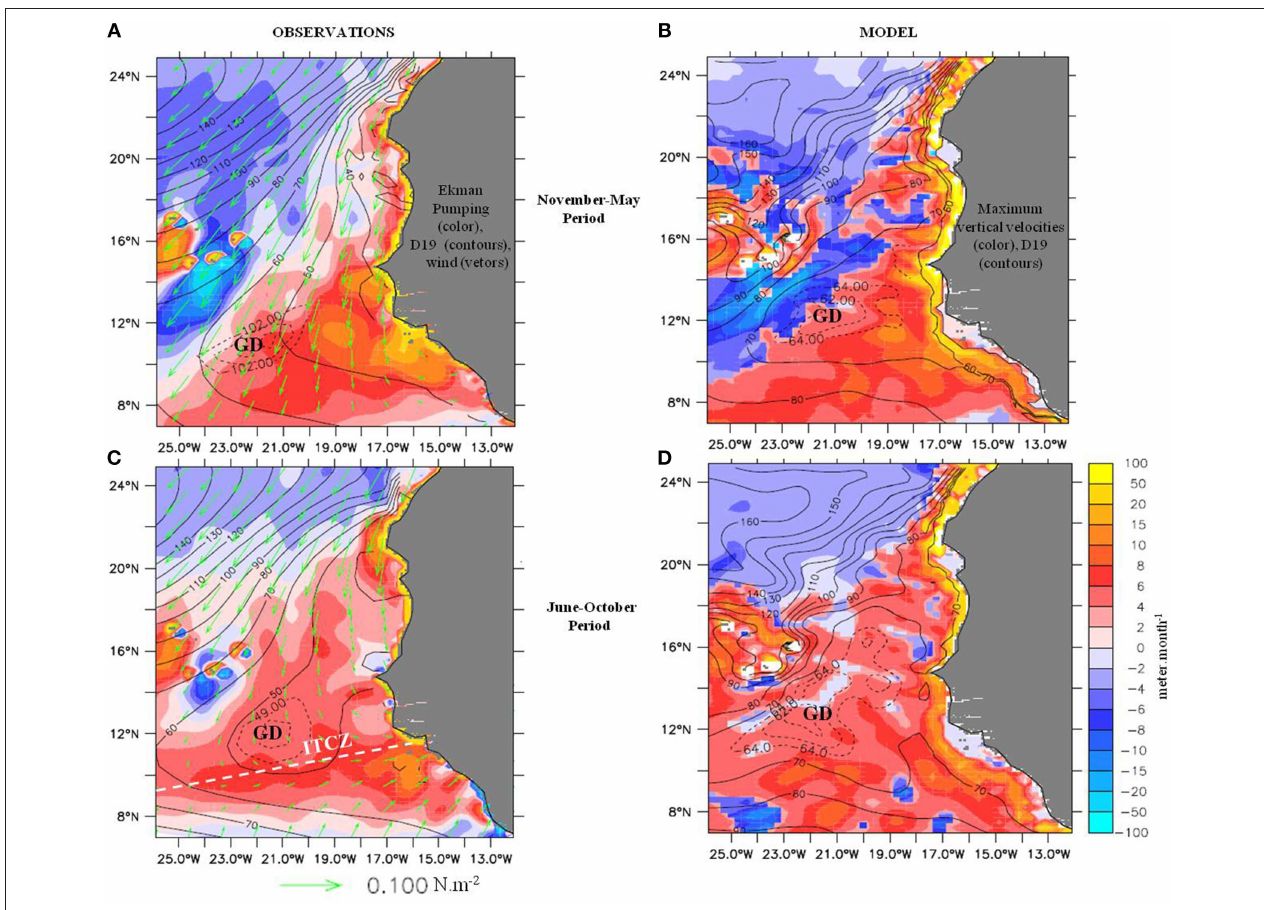
FIGURE 4 | Ekman pumping (shading, m.month − 1 ), 19 ◦ C isotherm depth (black contours, m) and wind stress (green vectors, N.m − 2 ) from observations, averaged over (A) the CP(November–May) period, and (C) WP (June–October) period. Maximum vertical velocities between surface and thermocline (shading, m.month − 1 ) and 19 ◦ C isotherm depth (black contours, m) for the simulation, averaged over ( B ) the November-May CP period, and (D) June–October WP period. GD, Guinea